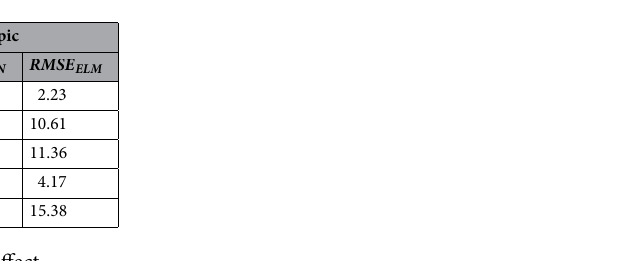
Table 11. The RMSE of relative MR effect.